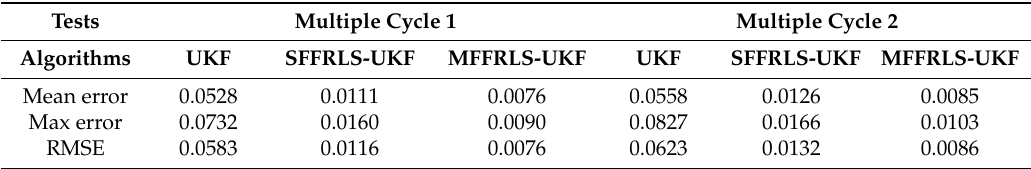
Figure 11. SOC estimation result and SOC error of UKF, SFFRLS-UKF and MFFRLS-UKF during multiple cycles tests under variable temperature: ( a , b ) Multiple Cycle 1; ( c , d ) Multiple Cycle 2.